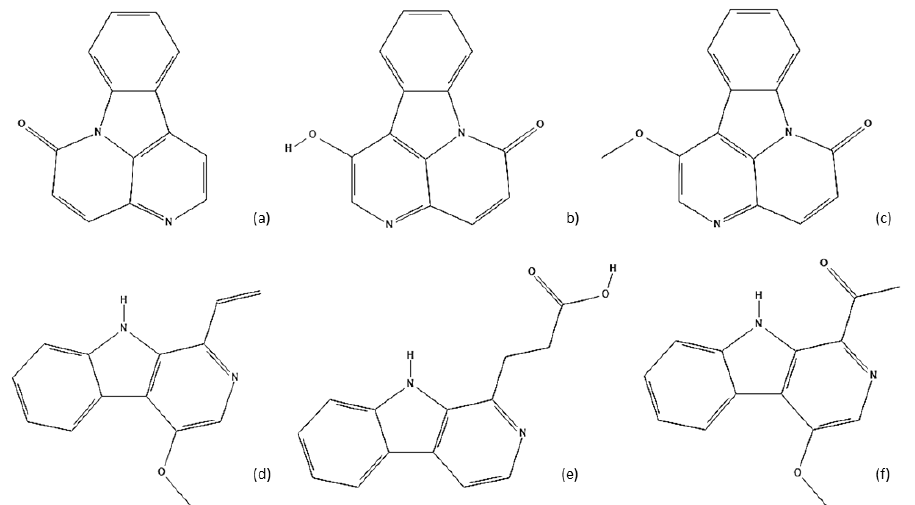
Figure 2. Some examples of alkaloids identified in A. altissima : ( a ) Canthin-6-one; ( b ) 1-Hydroxycanthin-6-one; ( c ) 1-Methoxycanthin-6-one; ( d ) 4-methoxy-1-vinyl-β-carboline; ( e ) β-carboline-1-propionic acid; ( f ) 1-Acetyl-4-methoxy-β-carboline.